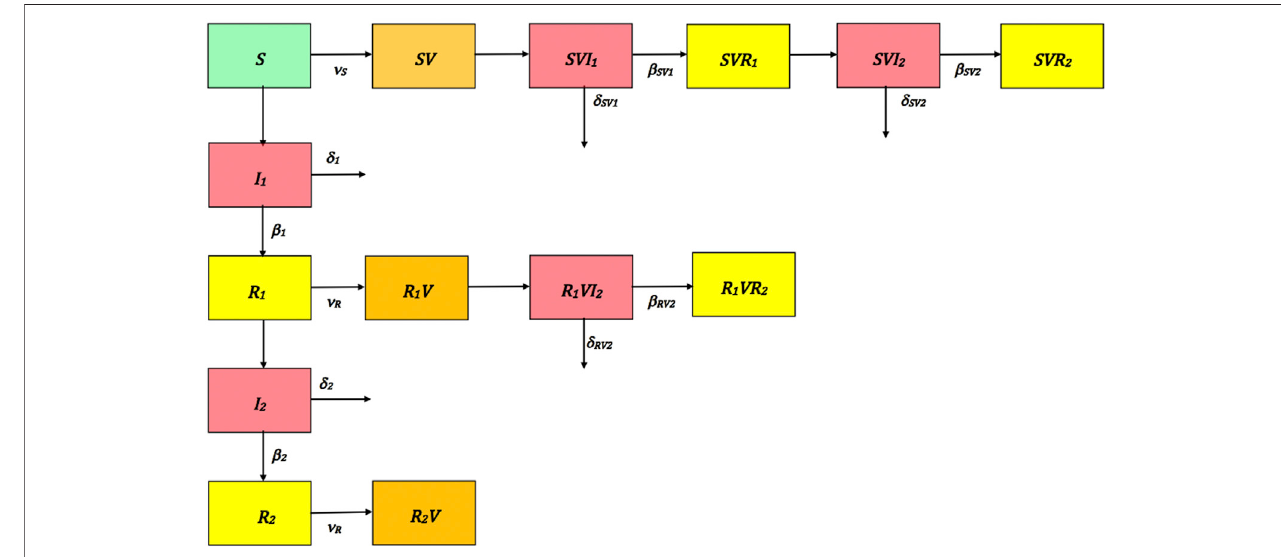
FIGURE 1 | Compartments of the model with